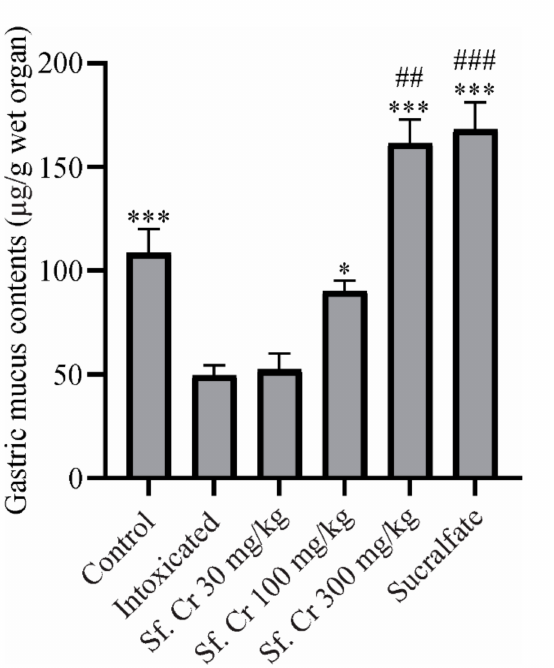
Figure 4. Effect of Sf.Cr on gastric mucus contents. Values are expressed as Mean ± SEM. Significance was determined by one way ANOVA followed by Dunnett’s test. Values are considered as significant (*) if p < 0.05, highly significant (***) if p < 0.001 compared with intoxicated group, and (##) if p < 0.01, (###) p < 0.001 compared with normal control